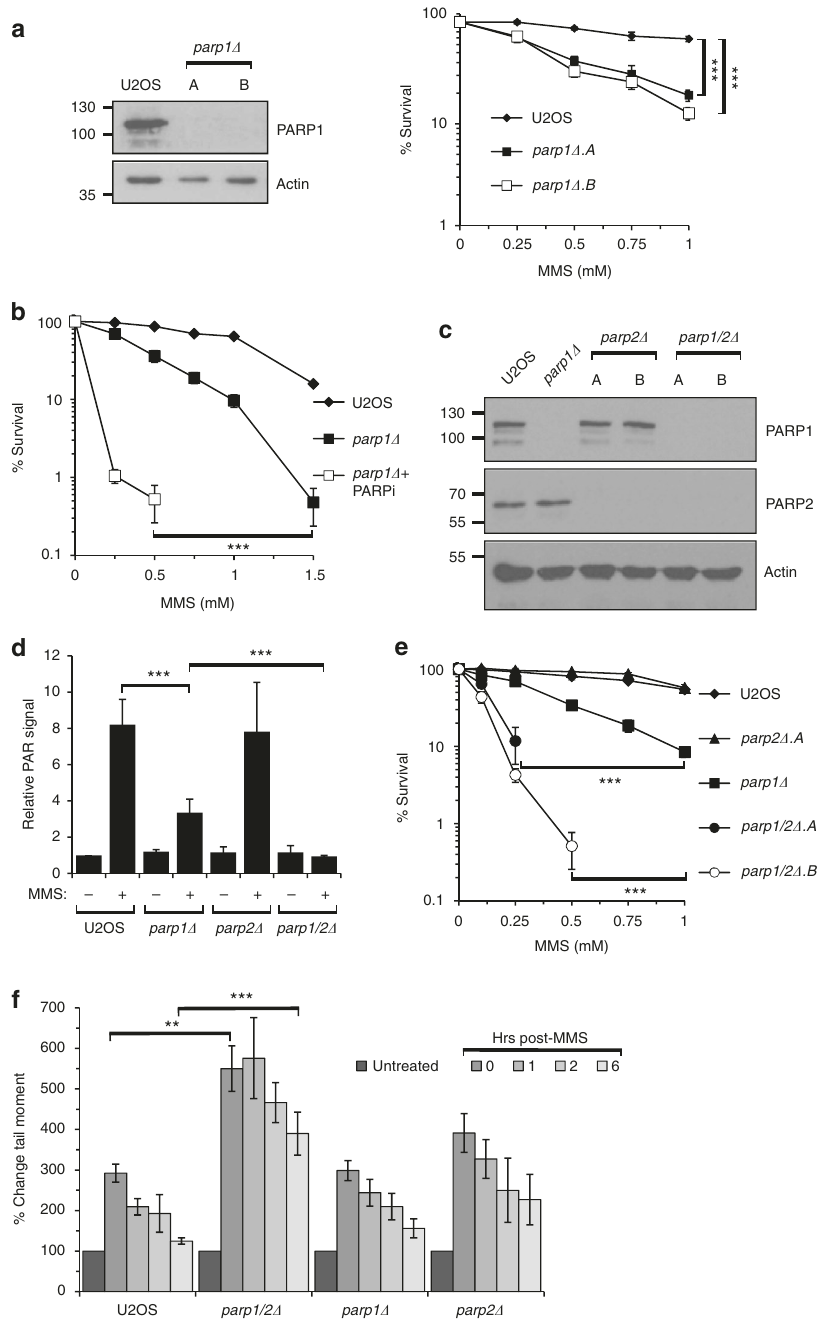
Fig. 1 PARP1 and PARP2 are redundant in the cellular response to MMS-induced DNA damage. a Whole cell extracts were prepared from U2OS or two independent parp1 Δ cell lines and western blotting performed with the indicated antibodies (left panel). U2OS or parp1 Δ cell lines were exposed to MMS and cell survival assessed by clonogenic assays (right panel). Error bars represent the standard error of the mean (SEM) from three independent experiments. Statistical signi fi cance was determined by two-way ANOVA (*** p < 0.001). b U2OS or parp1 Δ cell lines, with or without exposure to Olaparib (PARPi), were exposed to MMS and cell survival assessed by clonogenic assays. Error bars represent the SEM from three independent experiments. Statistical signi fi cance was determined as in a . c Whole cell extracts were prepared from U2OS, parp1 Δ , parp2 Δ and parp1/2 Δ cells and Western blotting performed using the indicated antibodies. d The indicated cell lines were left untreated (-) or exposed to 1.5 mM MMS ( + ) for 1 h and nuclear ADP- ribosylation analysed by immuno fl uorescence. Error bars represent the SEM from three independent experiments. Statistical signi fi cance was determined using a two-tailed Student ’ s t -test (** p < 0.01; *** p < 0.001). e U2OS, parp1 Δ , parp2 Δ or parp1/2 Δ cell lines were exposed to MMS and cell survival assessed by clonogenic assays. Error bars represent the SEM from three independent experiments. Statistical signi fi cance was determined as in a . f Cells were treated with 250 µ M MMS for 1 h, before recovery in fresh media. Samples were taken at the indicated times post treatment and the alkaline comet assay used to reveal strand breaks and alkali-labile sites. Comet data was normalised to the untreated sample. Error bars represent mean values± SD from at least six independent experiments. Statistical signi fi cance was determined as in